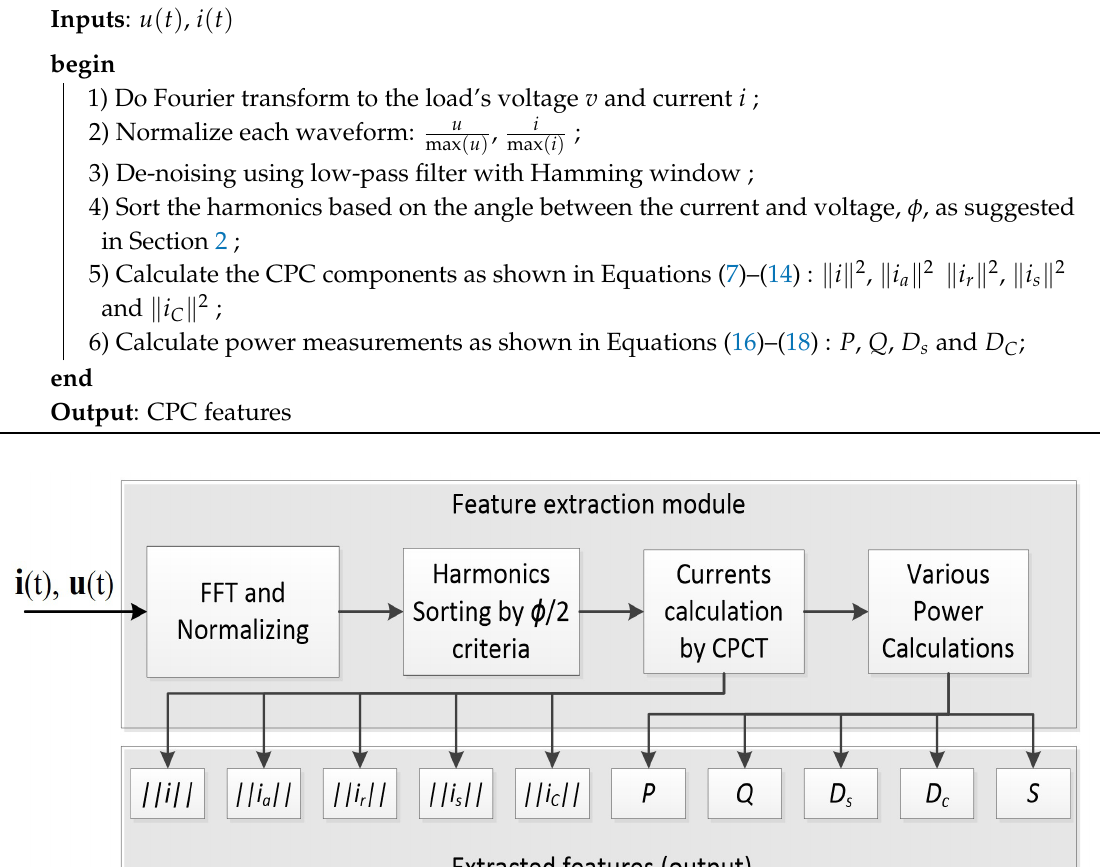
Algorithm 1: CPC feature extraction process.